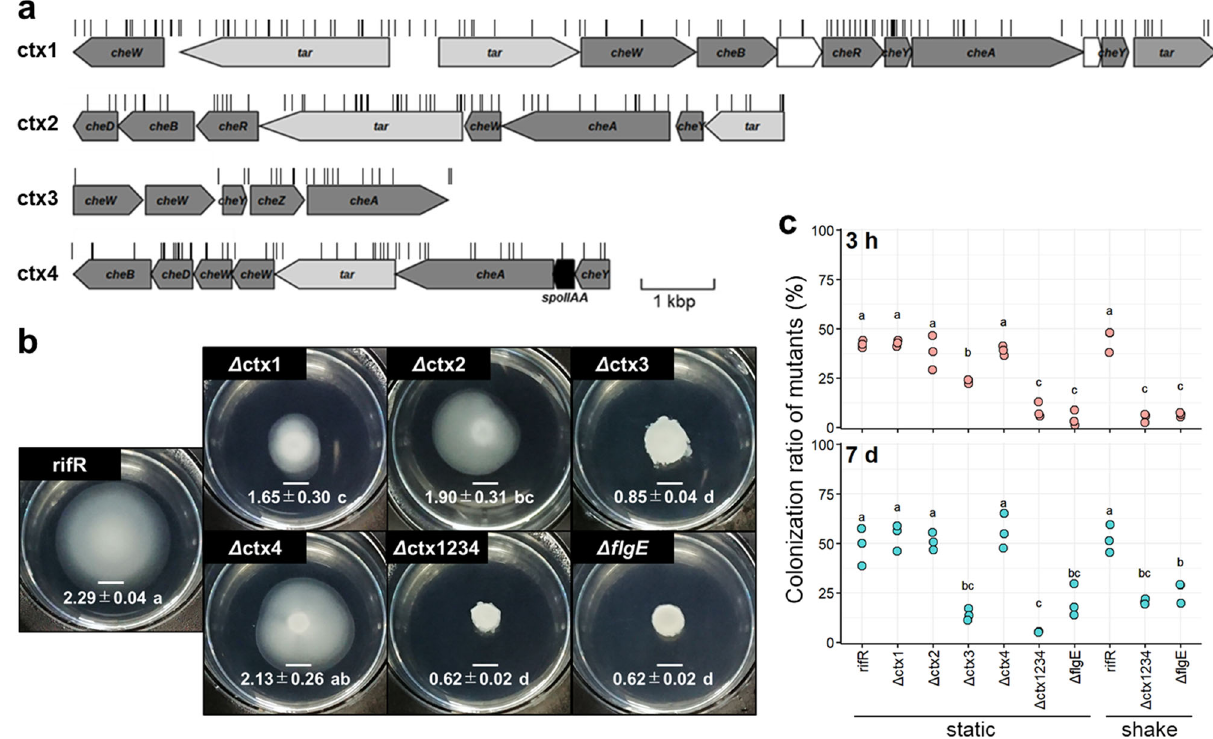
Fig. 5 Contribution of chemotaxis to colonization and fi tness. a Gene maps of four chemotaxis gene clusters in the strain H3 genome. Depleted or enriched genes were not found in the four-gene clusters (Supplementary Data 7). b Chemotactic motility of the parental strain (rifR), mutants lacking each and all four chemotaxis gene clusters ( Δ ctx1, Δ ctx2, Δ ctx3, Δ ctx4, and Δ ctx1234), and nonmotile mutant ( Δ fl gE ) on a soft agar plate. The average diameter (cm ± SD) of colonies is shown. Scale bar represents 5 mm. c Results of co-inoculation assays against the wild-type strain under static and shaken conditions. Plots represent the ratio of mutant cells colonized on duckweed. Different lowercase letters denote signi fi cant differences ( P < 0.05; Tukey ’ s HSD